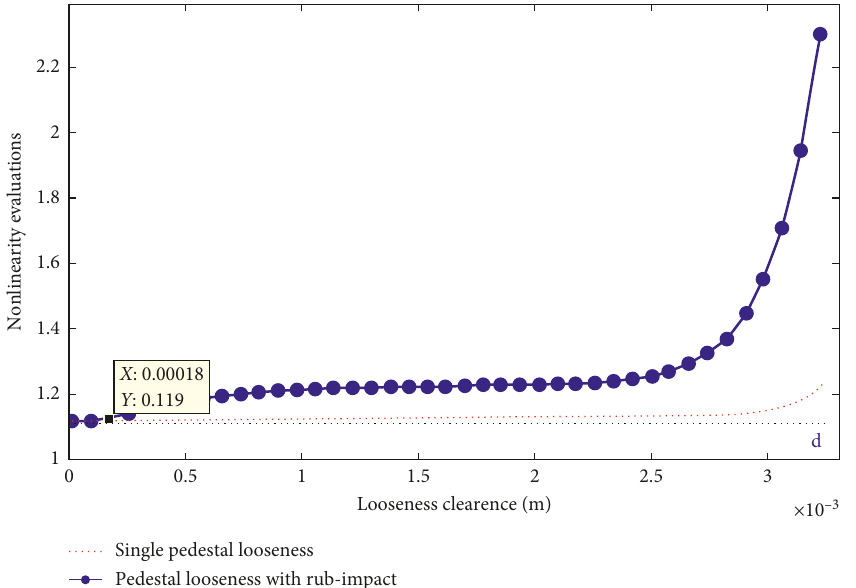
Figure 20: Comparisons for nonlinearity evaluations of pedestal